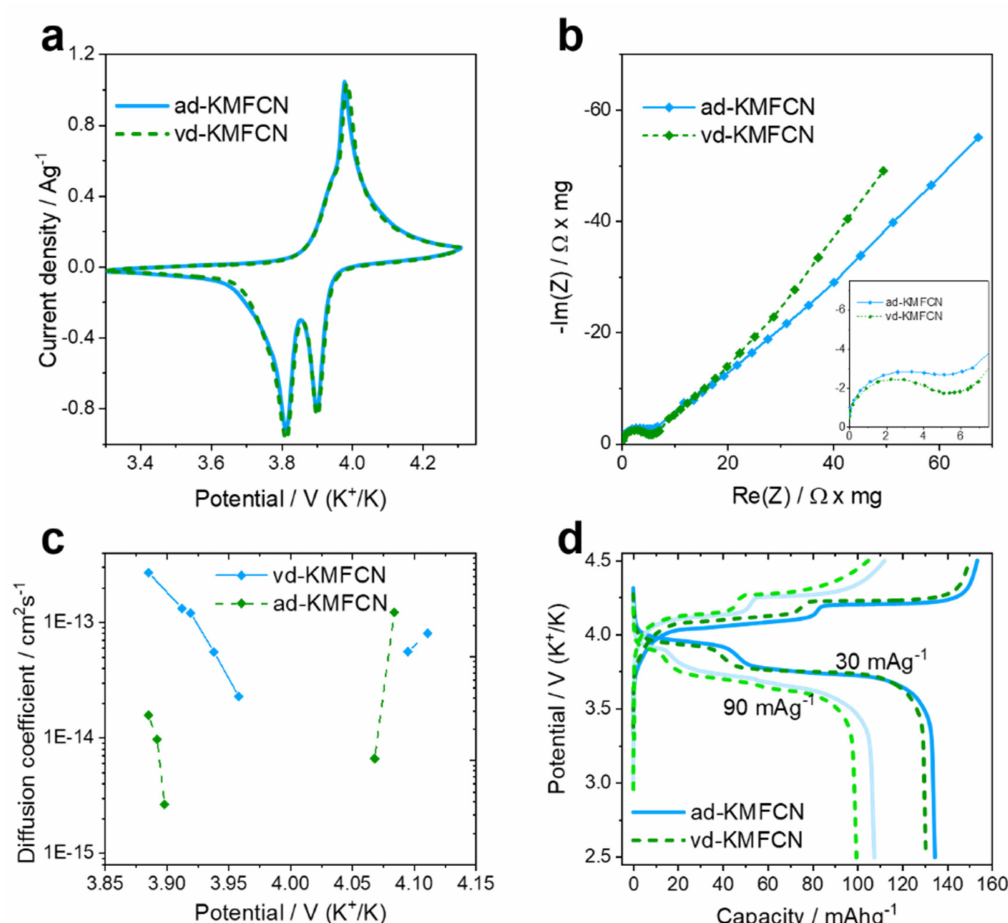
Figure 5. CVs at 50 µ V s − 1 scan rate ( a ), EIS spectra at 3.892 V vs. K + /K ( b ), apparent diffusion coefficients ( c ) of big particles; ( d ) galvanostatic charge/discharge profiles (1st cycles of 30 mA/g (C/5 rate) and 90 mA/g (C/2 rate) current density, 2-electrode cell) of small nanosized particles of ad- and vd-KMFCN in 0.5 M KPF 6 EC:PC (v:v) + 2 mass. % FEC